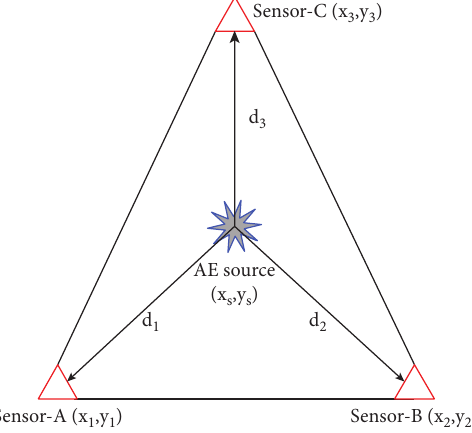
Figure 10: The schematic diagram of acoustic emission source